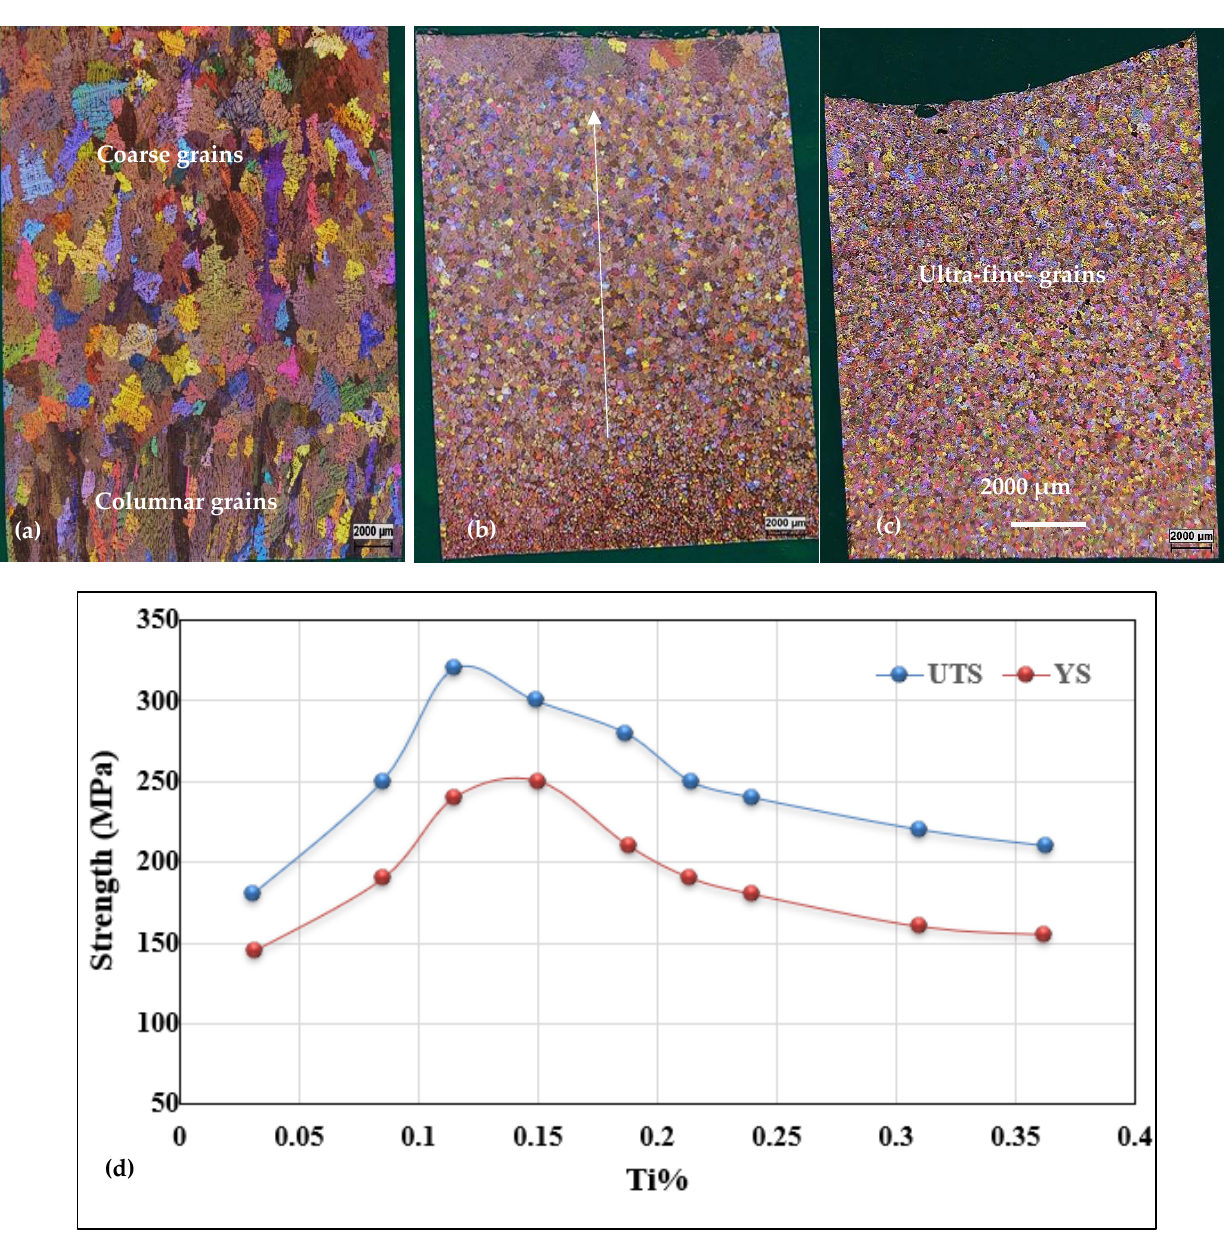
Figure 13. Macrostructure of the A356 alloy with ( a ) no grain refining; ( b ) addition of 0.15%Ti- note gradual decease in grain size as indicated by the white arrow; ( c ) 500 ppm B, casting was made in a permanant metallic mold (dimensions: 0.5 cm × 8 cm × 10 cm); ( d ) strength− Ti% relationship.